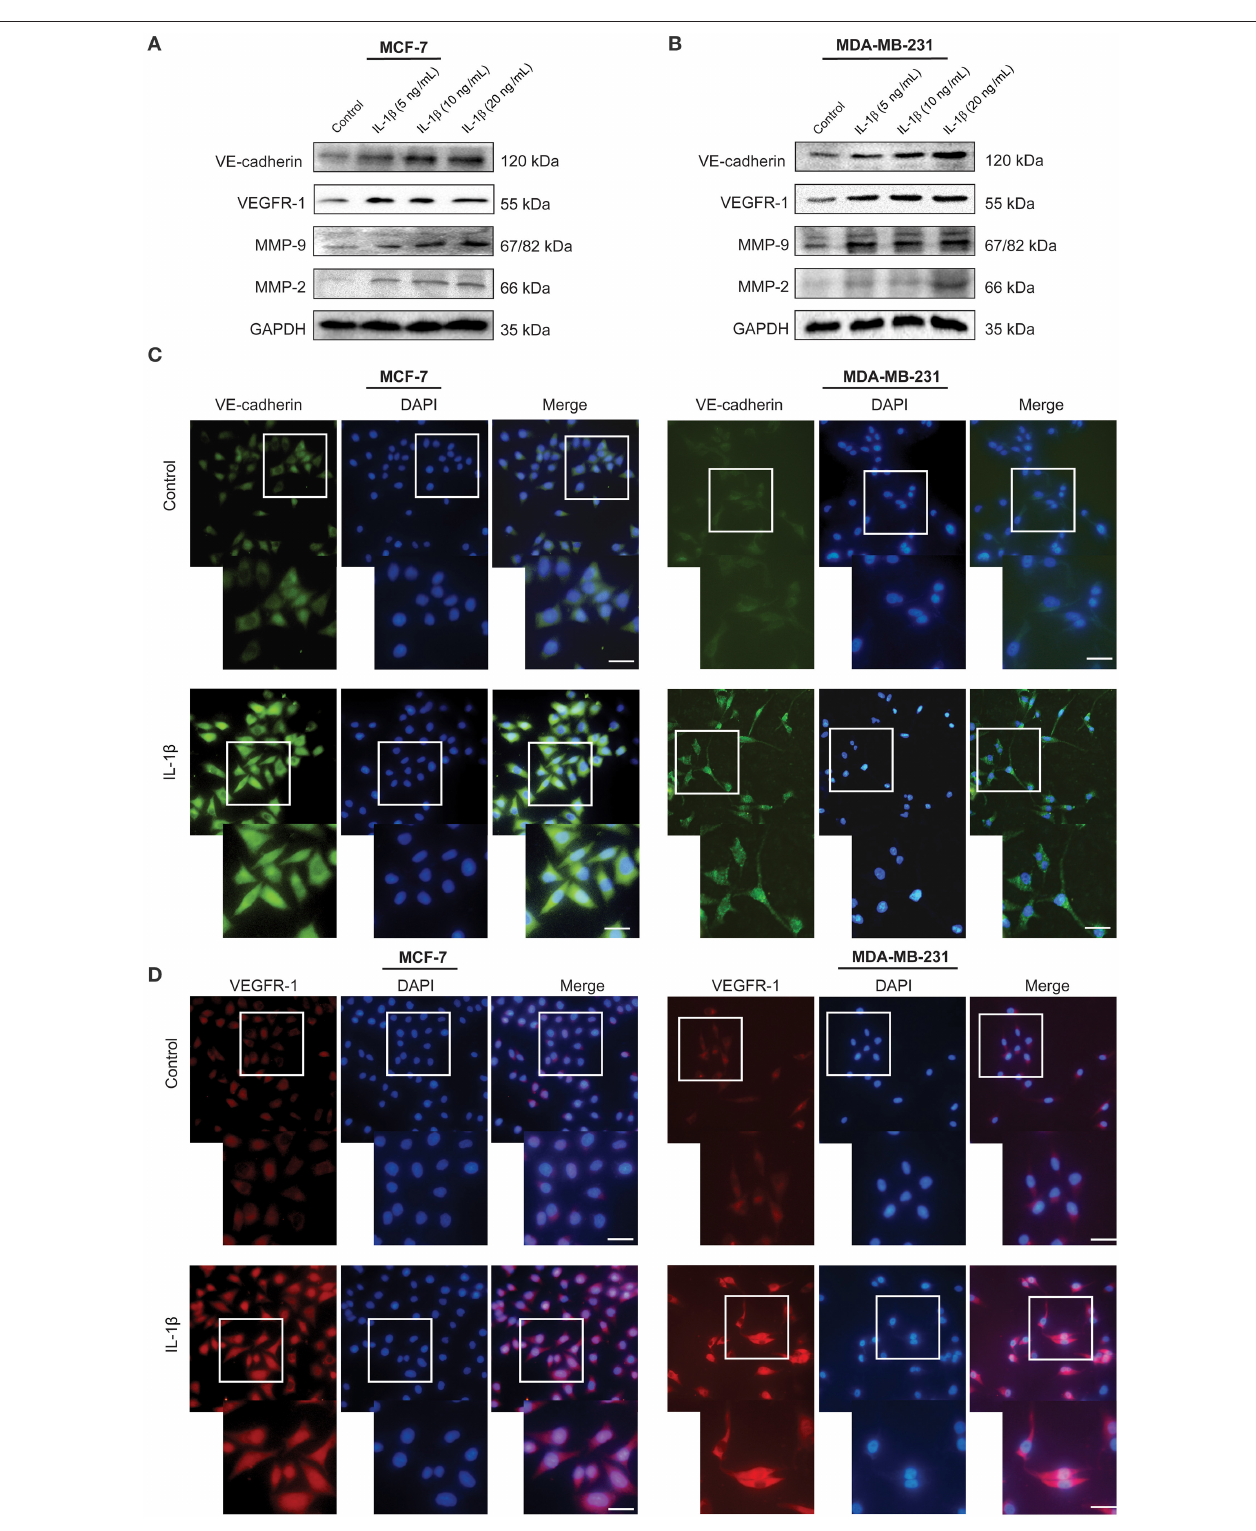
FIGURE 1 | VM biomarkers are highly expressed in IL-1 β treated breast cancer cells. (A,B) Western blot analysis of VM biomarkers (VE-cadherin, VEGFR-1, MMP-9, and MMP-2) in IL-1 β (0, 5, 10, and 20ng/ml) treated MCF-7 and MDA-MB-231 cells. (C,D) Immunofluorescent staining of VE-cadherin and VEGFR-1 in IL-1 β (15ng/ml) treated MCF-7 and MDA-MB-231 cells. Scale bar: 20 µ m.